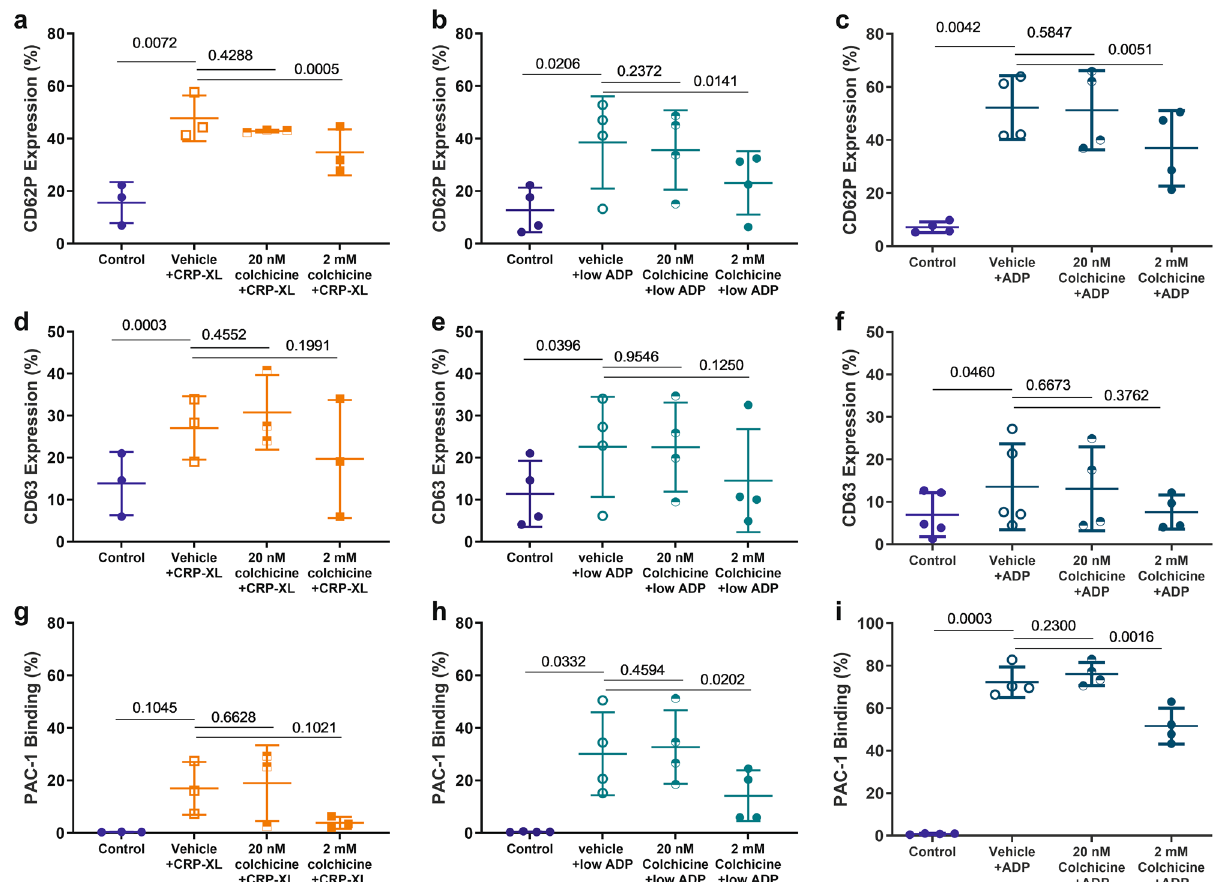
Figure 6. Effect of colchicine on P-selectin, CD63 expression and conformational change of GPIIb/IIIa. Flow cytometry was performed to assess the cell surface expression of P-selectin/CD62P, CD63 and conformational change of GPIIb/IIIa in response to stimulation with 0.2 µg/mL CRP-XL, 0.5 µM ADP or 2 µM ADP after preincubation with vehicle or colchicine (20 nM and 2 mM). A significant reduction in CD62P expression was only observed in those samples pre-incubated with high concentrations of colchicine [( a ) CRP-XL, p = 0.0005; ( b ) 0.5 µM ADP, p = 0.014 and ( c ) 2 µM ADP, p = 0.005]. There was no significant difference in CD63 expression in response to colchicine under any of the conditions examined [( d ) CRP-XL, ( e ) 0.5 µM ADP and ( f ) 2 µM ADP]. A significant reduction was only observed in GPIIb/IIIa conformational change (PAC-1 binding) in those samples pre-incubated with high concentrations of colchicine and stimulated with ADP, no change was observed in platelets stimulated with CRP-XL ( g ) [( h ) 0.5 µM ADP, p = 0.02 and ( i ) 2 µM ADP, p = 0.002]. Statistical significance was determined by comparing conditions with the vehicle control using either paired t test or Wilcoxon matched pair rank test as appropriate. Data presented as mean ± SD, n = GSAO + /P-selectin + platelets are a subset of stimulated platelets that actively support coagulation by providing a procoagulant surface during thrombosis 33,54 . In our study, high concentrations of colchicine suppressed the formation of procoagulant (GSAO + /P-selectin + ) platelets in response to thrombin + collagen stimulation, without inhibiting total P-selectin expression in platelets. This implies a relatively specific inhibition of procoagulant platelet formation under these conditions. Collagen and thrombin are both demonstrable in atherosclerotic plaque and suppressing the formation of procoagulant platelets in response to these agonists may be particularly relevant in the context of coronary events, an area in which colchicine has shown recent promise 5,9,11 . Target- ing the procoagulant platelet in atherothrombosis is attractive as it would reduce fibrin formation at the site of platelet aggregation without affecting fibrin formation at the endothelial surface, thus theoretically limiting bleeding complications 55 . Currently, there are very few therapeutic interventions that demonstrate reduction in procoagulant platelet formation. Acetazolamide, targeting aquaporin formation, and potassium and calcium channel inhibitors inhibit platelet shape change and platelet phosphatidylserine exposure during this process 56–58 . Whether clinical treatment with colchicine affects procoagulant platelet formation in vivo is currently unknown. Colchicine binds platelet microtubules 25 , and perturbed microtubule rearrangement could affect platelet shape change in the process of procoagulant platelet formation, but the mechanisms by which colchicine inhibits procoagulant platelet formation in vitro require further investigation. In general terms, the effects of colchicine on platelets may involve either microtubule disassembly or direct action on the platelet membrane. The lack of apparent influx of colchicine into platelets under conditions when platelet aggregation was inhibited 22 suggests actions on the platelet plasma membrane. However, most reduction